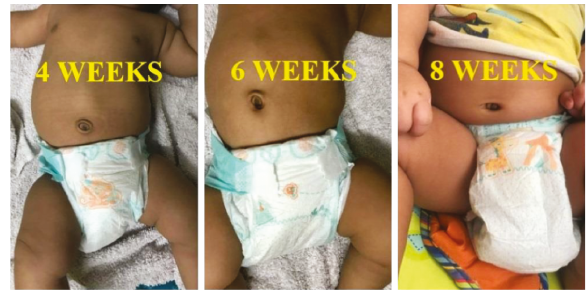
Figure 3: Resolution of infantile umbilical